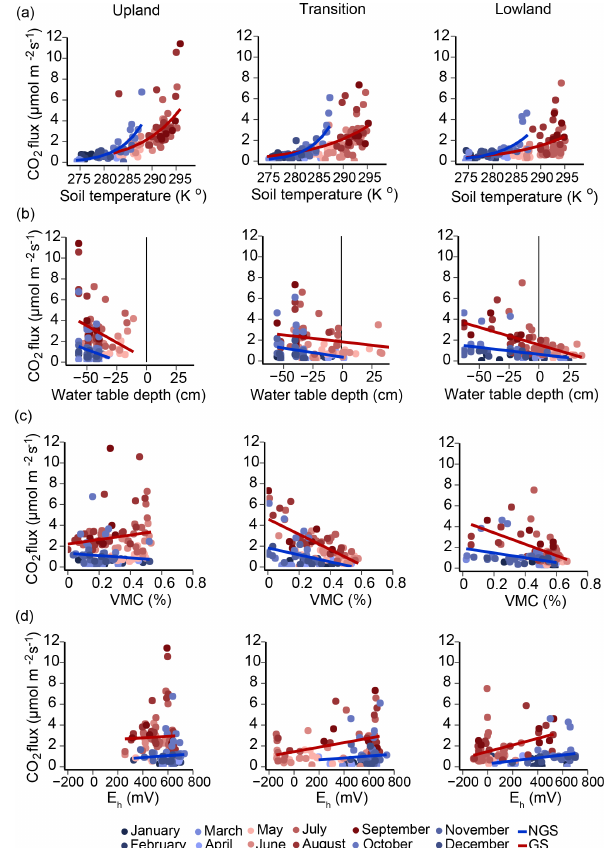
Figure 3. Pairwise regressions between soil CO 2 efflux and soil temperature, water table depth, moisture content, and redox poten- tial. Monthly averages for each environmental variable, recorded in six replicate upland–lowland transects over a full year, were combined for regression analyses. Regression analyses were con- ducted for both growing (red-scale markers) and non-growing sea- son (blue-scale markers). (a) Relationship between soil tempera- ture at 10cm depth and soil respiration modeled using the Arrhe- nius equation. (b) Linear regressions of water table depths against CO 2 efflux. Water table depths less than zero are below soil sur- face; depths greater than zero are above soil surface. (c) Linear re- gressions of volumetric moisture contents at 10cm depth plotted against CO 2 efflux. (d) Linear regressions of soil redox potentials at 15cm depth plotted against CO 2 efflux. Growing season (GS) and non-growing season (NGS) fits are shown for each